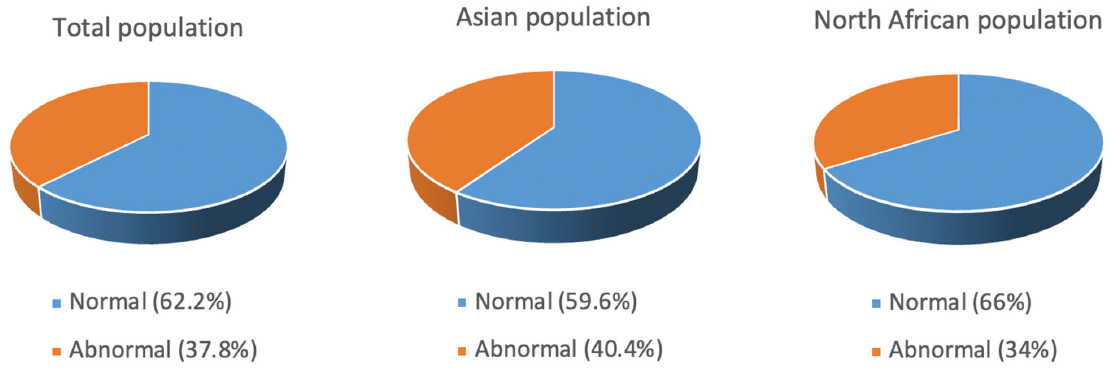
Figure 7. Karyotype distribution in the total population, Asian population, and North African pop- ulation.